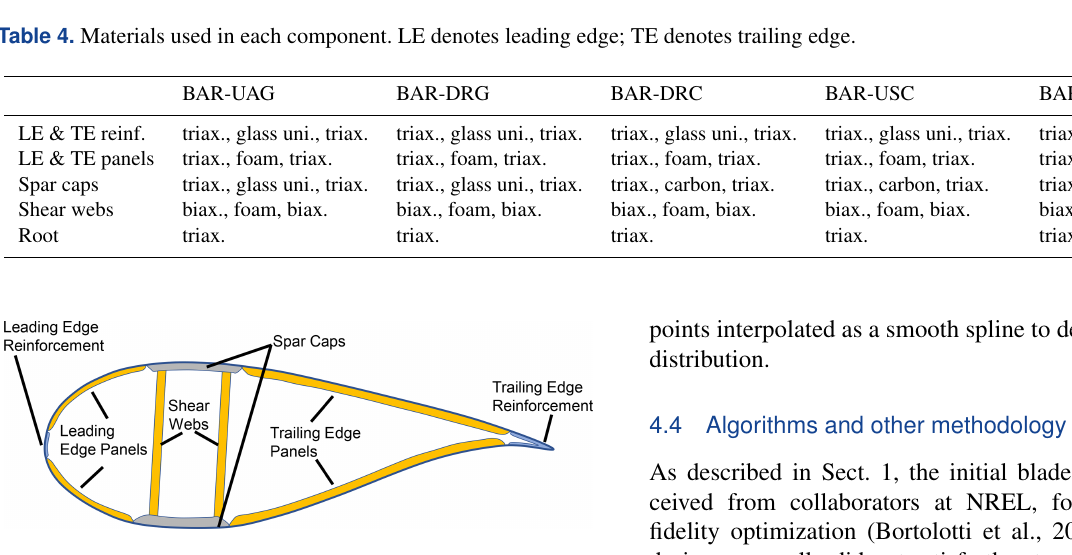
Figure 6. Cross-sectional component breakdown of a wind turbine